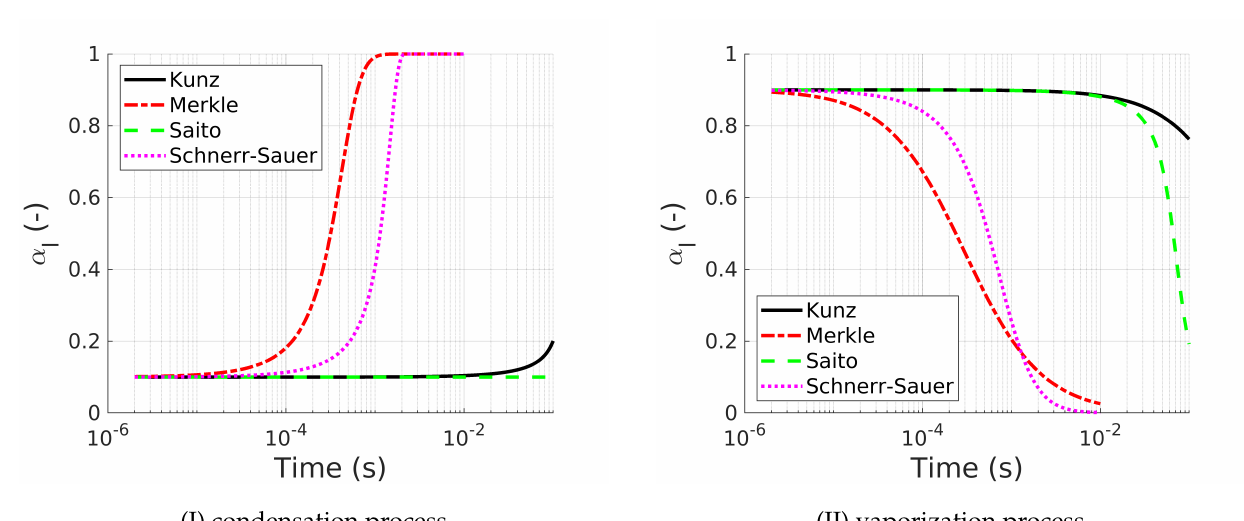
Figure 1. Condensation ( left panel ) and vaporization ( right panel ) processes, evaluated with standard